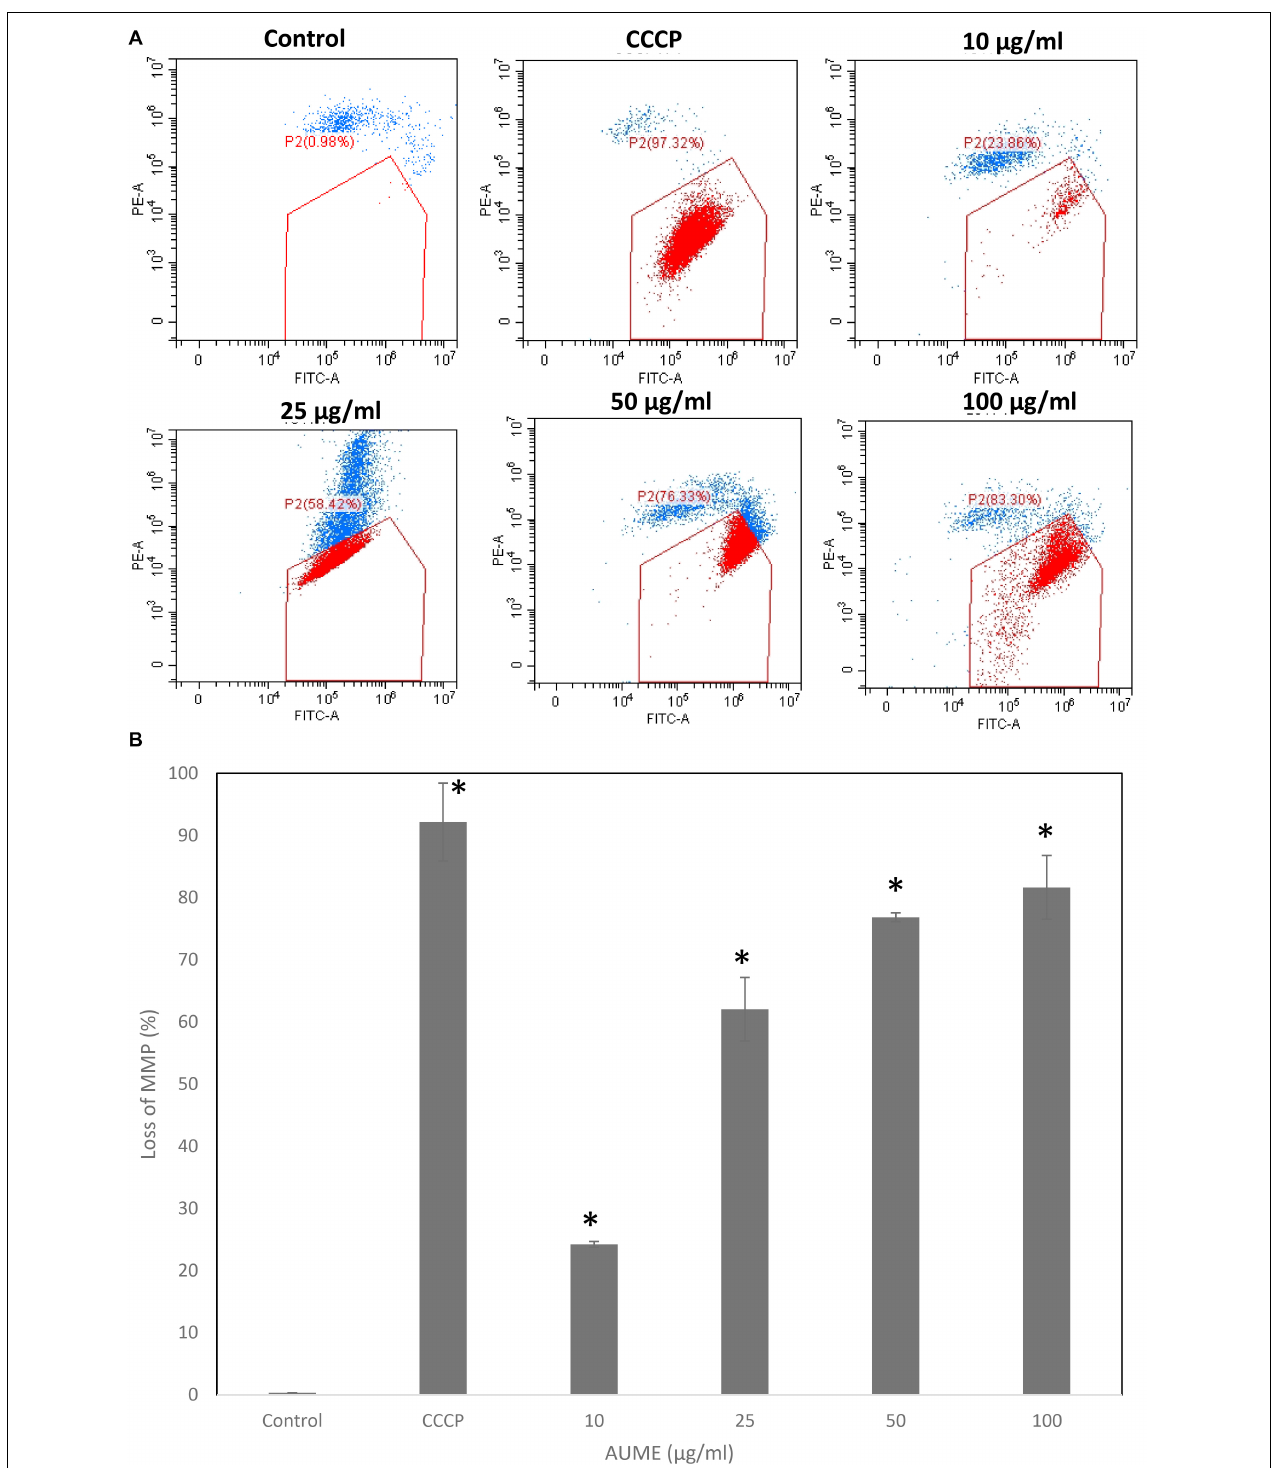
FIGURE 5 | (A) Loss of mitochondrial membrane potential by AUME as measured by the percentage of JC-1 monomers. HeLa cells were treated with indicated concentration of AUME for 48 h. After JC1 staining, cells were analyzed by FACS. (B) The bar diagram represents the percentage of loss in MMP in HeLa cells. Values are given as means ± SD of three replicates in each group, p < 0.05, *statistically significant when compared to control.